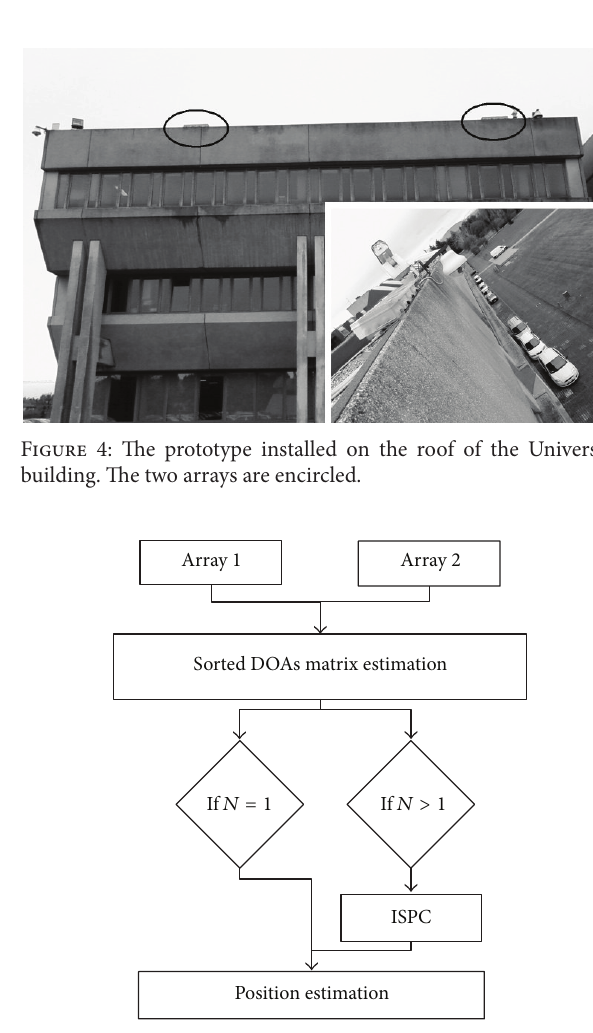
Figure 5: The block diagram of the processor showing the data flow of all of the tasks of the experimental